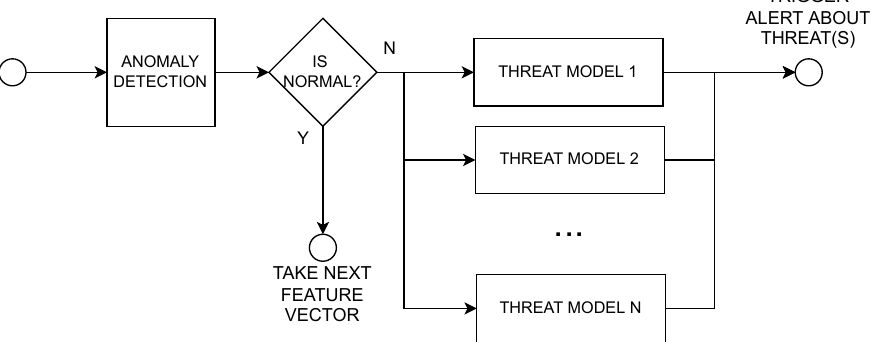
Figure 3. The model cascade used for anomaly detection and threat identification (there are two steps of classification in the proposed approach: anomaly detection and threat